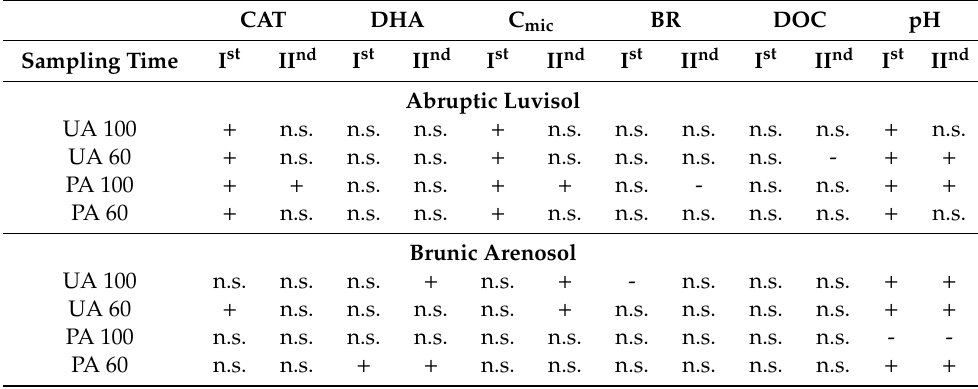
Table 2. Determining the impact of biofertilizers on microbiological parameters (CAT—catalase activity, DHA—dehydrogenase activity, C mic —soil microbial biomass, BR—basic respiration, DOC—dissolved organic carbon content, pH of Abruptic Luvisol and Brunic Arenosol collected one week (I st sampling time) and six months (II nd sampling time) after fertilization with optimal (100%) and reduced (60%) dose of UA—urea, and